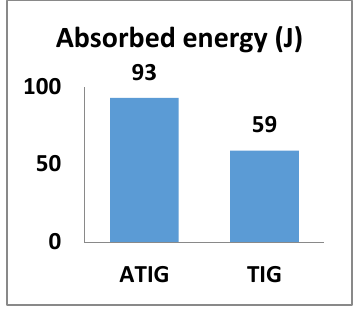
Figure 14. Impact test results of ATIG and TIG in FZ.